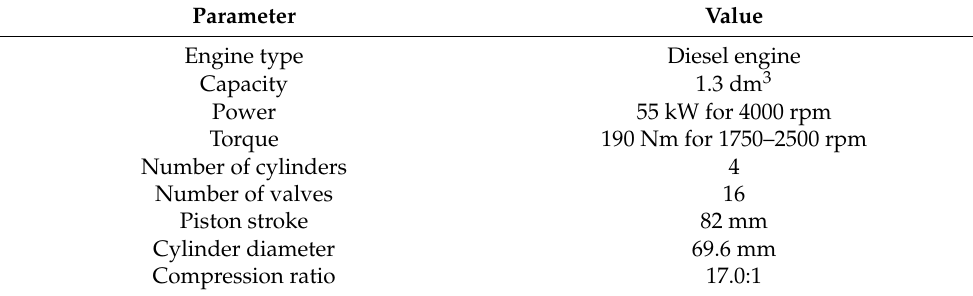
Table 1. Engine’s